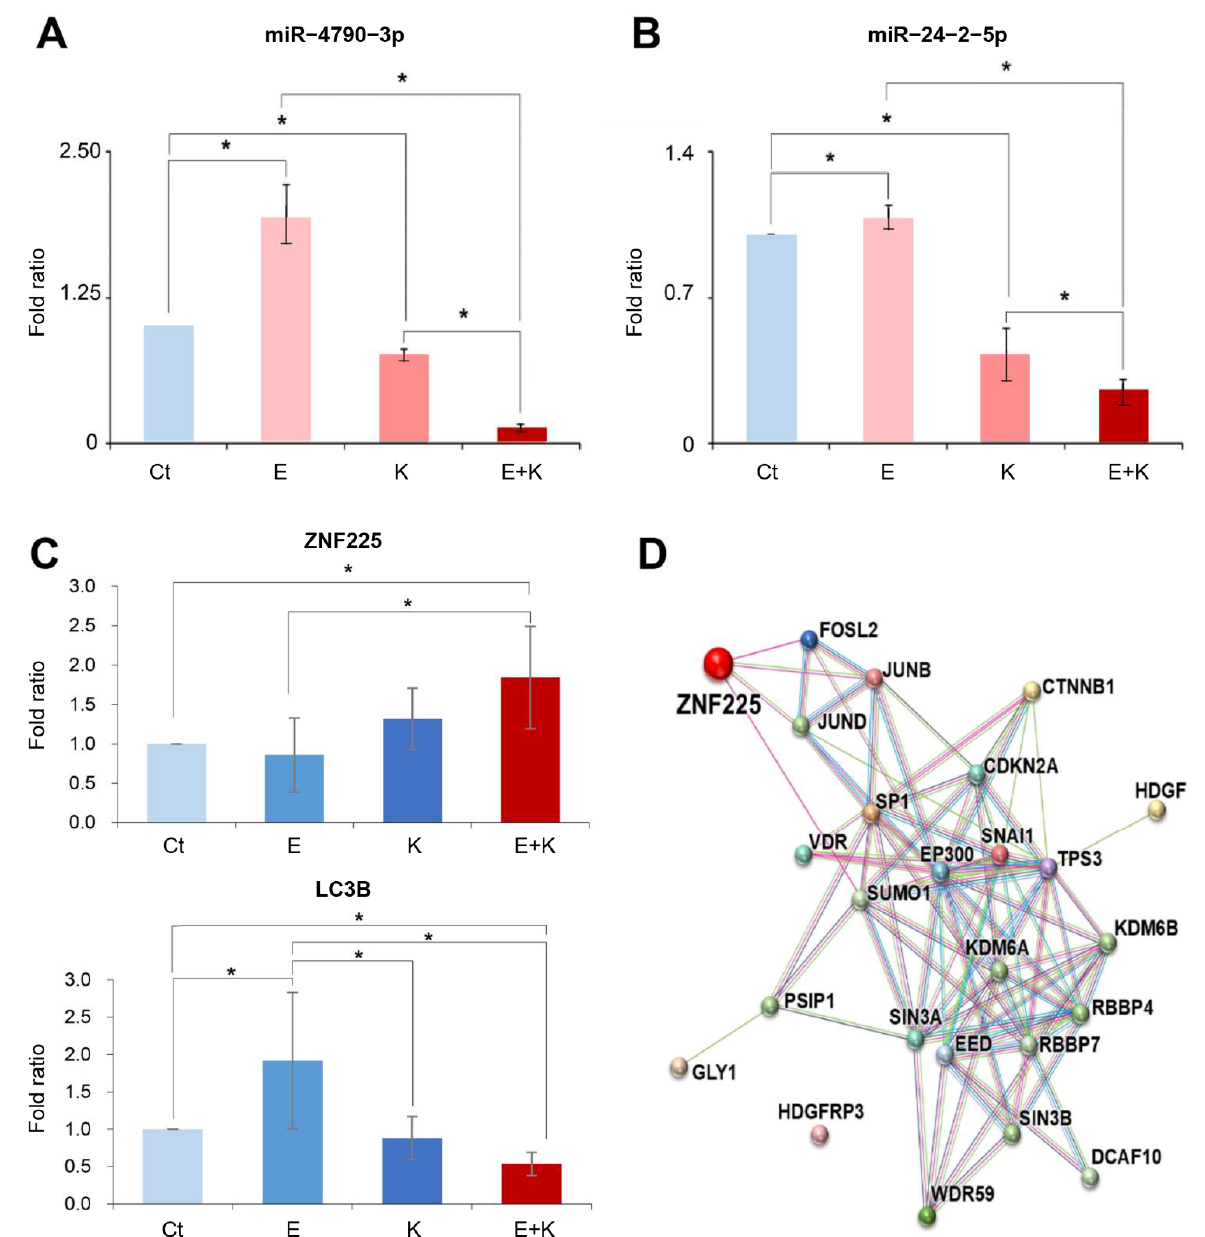
Figure 2. Changes in miR-4790-3p and miR-24-2-5p after everolimus and Ku0063794 mono- and combination therapies. ( A , B ) Real-time PCR showing the expression of miR-4790-3p and miR-24-2-5p in HepG2 cells after individual treatments. Compared to the control group, the expression of miR-4790-3p and miR-24-2-5p was increased after everolimus monotherapy, slightly decreased after Ku0063794 monotherapy, and significantly decreased after the combination therapy. ( C ) Real-time PCR showing the expression of Zinc finger protein 225 (ZNF225) and LC3B after the combination therapy. ZNF225 is known to be the target mRNA of miR-4790-3p. The mRNA expression of ZNF225 and LC3B was significantly up- and downregulated following combination therapy, respectively. ( D ) Potential network interactions of ZNF225 with JUNB, JUND, and FASL2 in the autophagy processes. ZNF225 is closely related with FOS like 2 (FOSL2), jun B proto-oncogene(JUNB), and jun D proto-oncogene(JUND), all of which play essential roles in the autophagic processes. The resulting network was computationally generated based on the databases (http://string-db.org. accessed date: 15th-July-2019). The colors of the lines denote activation (green), inhibition (red), and unspecified interactions (gray). Values are presented as means ± standard deviations of three independent experiments. Note: * p < 0.05. Abbreviations: E, everolimus; K, Ku0063794.